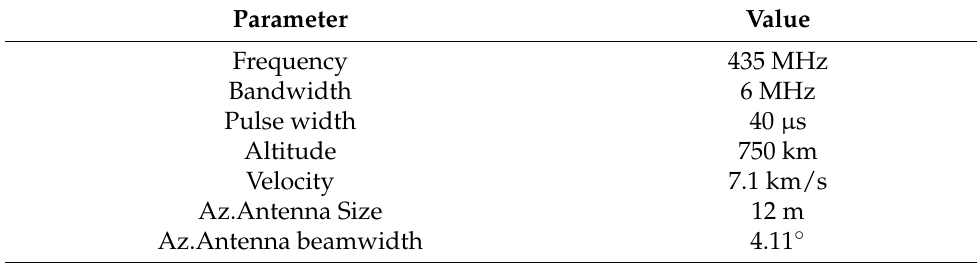
Table 1. P-band SAR System